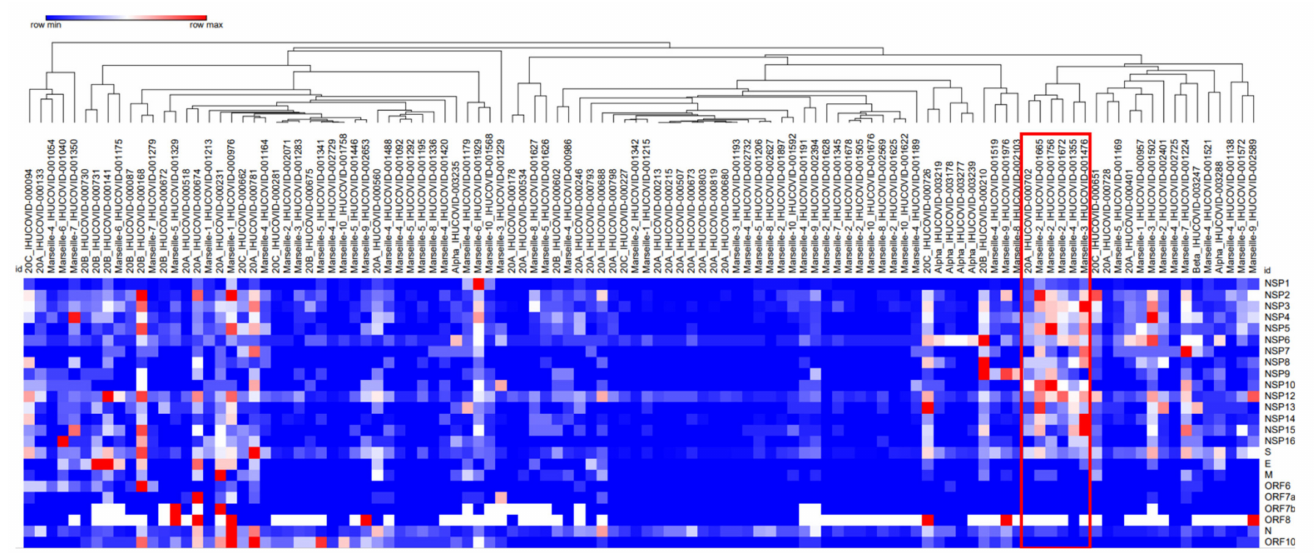
Figure 2. Hierarchical clustering of sets of SARS-CoV-2 next-generation sequencing reads for all 110 samples studied here based on mean intra-sample genetic diversity per 100 nucleotides for each gene. The diversity of all selected positions for this clustering was greater than 4%. The red box indicates a set of six genomes of different lineages with 920 positions exhibiting significant diversity, among which 91 were shared by all the six genomes.